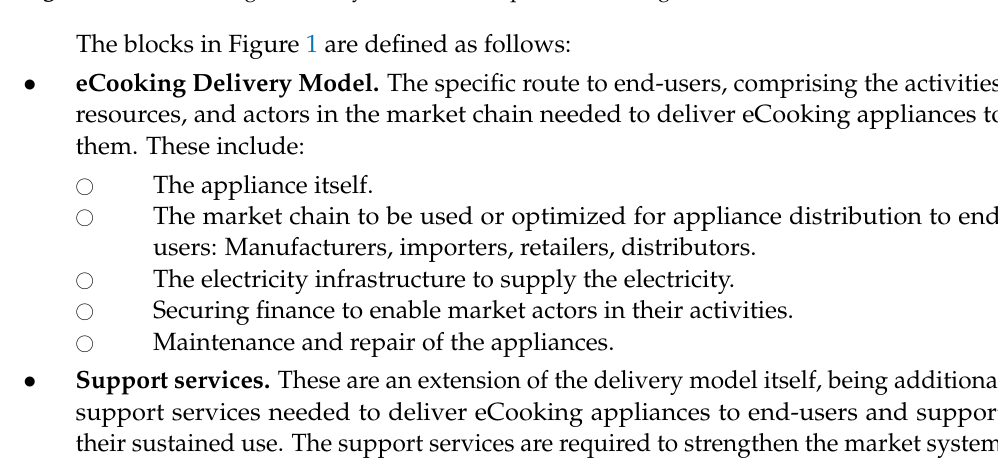
Figure 1. The eCooking Market System with component building blocks.